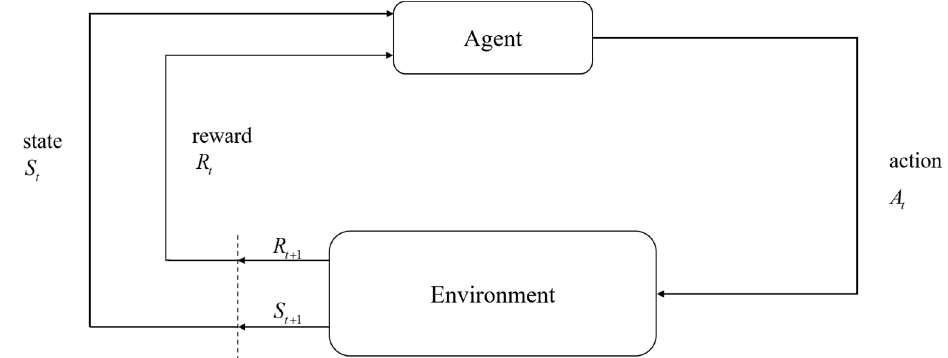
Figure 1. The interaction between the agent and the environment in the Markov decision process.